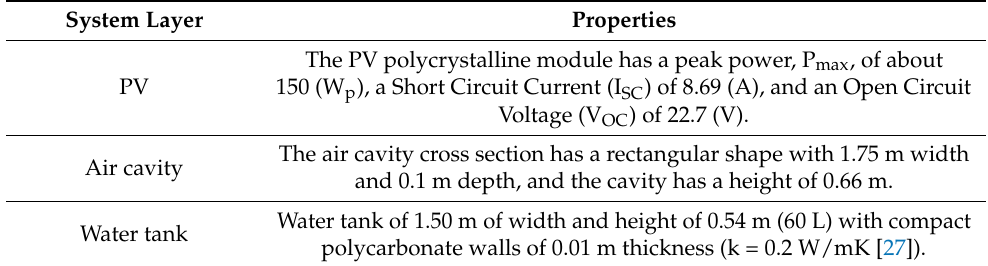
Table 1. Properties of the prototype components.